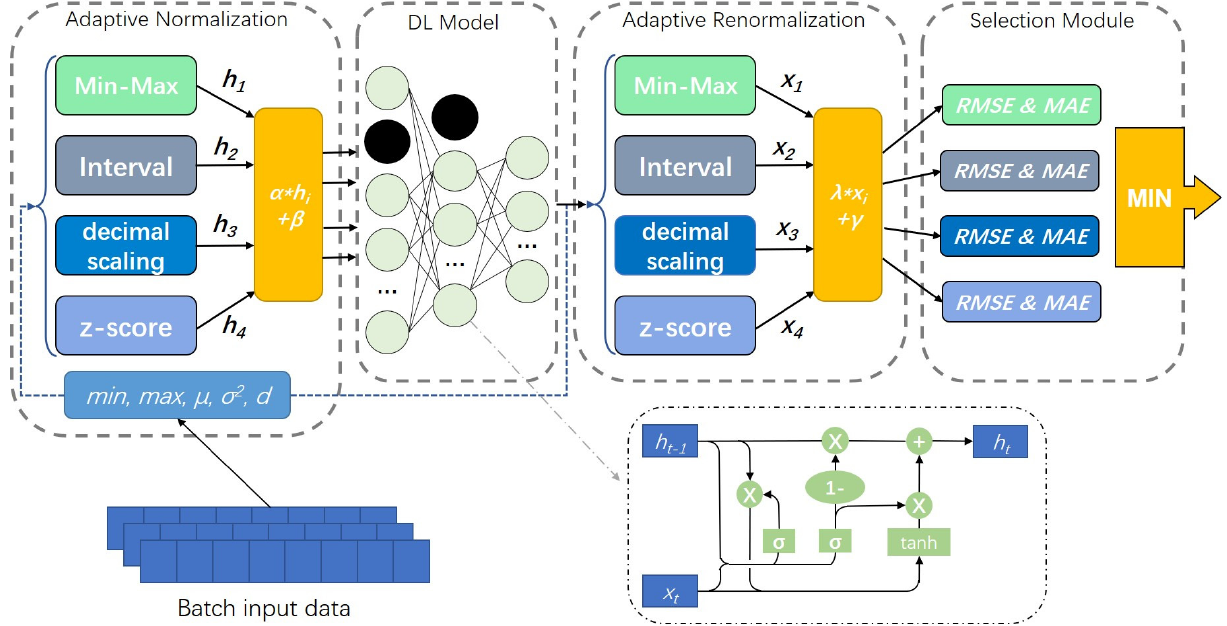
Figure 4. The RASN structure. The networks take over the input of the minibatch and later unify the data into a two-dimensional format; min , max , µ , σ 2 and d represent the calculated minimum, maximum, mean, variance, and fractional displacement values of the batch. These key computational parameters are shared between the normalization and denormalization layers (indicated by the blue dashed line); h i and x i represent the output of the normalization and renormalization layers, both processed by the scaling and translation factors. The activation functions used in the deep learning (DL) networks model are all tanh activation functions to reduce the influence on the model